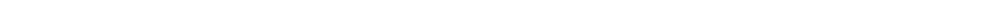
(see fi gure on previous page) Fig. 3 OTS167 inhibits eIF4B phosphorylation necessary for ef fi cient FLT3 protein expression. A Western Blot analysis of P-eIF4B(ser406), P- eIF4B(ser422) or t-eIF4B (eIF4B species detected in parallel blots) or P-4E-BP1(thr37/46), P-4E-BP1(ser65) or t-4E-BP1 (4E-BP1 species detected in parallel blots) in MV4:11 or MOLM-14 after treatment with 50 nM OTS167 or 50 nM gilteritinib for 8 h. Graphs show densities of P-eIF4B (cells stimulated for 8 or 17 h) or P-4E-BP1 (cells stimulated for 8 h) bands as a percent of total protein (eIF4B or 4E-BP1) (5 biological replicates for P-eIF4B, 2 biological replicate for P-4E-BP1)(samples run in parallel on 3 blots(b1-3)) B Western Blot analysis of FLT3 and eIF4B expression in MOLM-14 or MV4:11 72 h after transfection with two separate eIF4B-siRNAs compared to Control-siRNA. (3 biological replicates)(single blot) Graph shows densities of both FLT3 bands as a percent total of control cells for MV4:11 or MOLM-14 72 h after transfection with either eIF4B-siRNAs. C Western Blot analysis of FLT3 and MELK expression in MOLM-14 or MV4:11 at 48 or 72 h after transfection with MELK-siRNA compared to Control-siRNA. (4 biological replicates) (single blot) Graph shows densities of both FLT3 bands as a percent total of control cells for MV4:11 or MOLM-14 transfected with MELK-siRNAs at 48 or 72 h. (**** P < 0.0001, *** P < 0.001, ** P < 0.01, * P < 0.05, ns-not signi fi